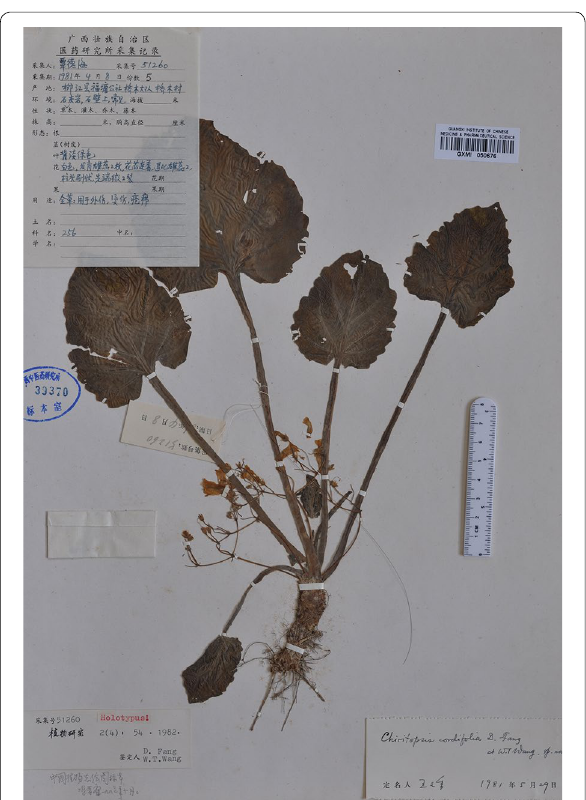
Fig. 8 Holotype of Chiritopsis repanda W.T.Wang [ Tian’e Exped. 4 ‑ 6 ‑ 654 (GXMI)]